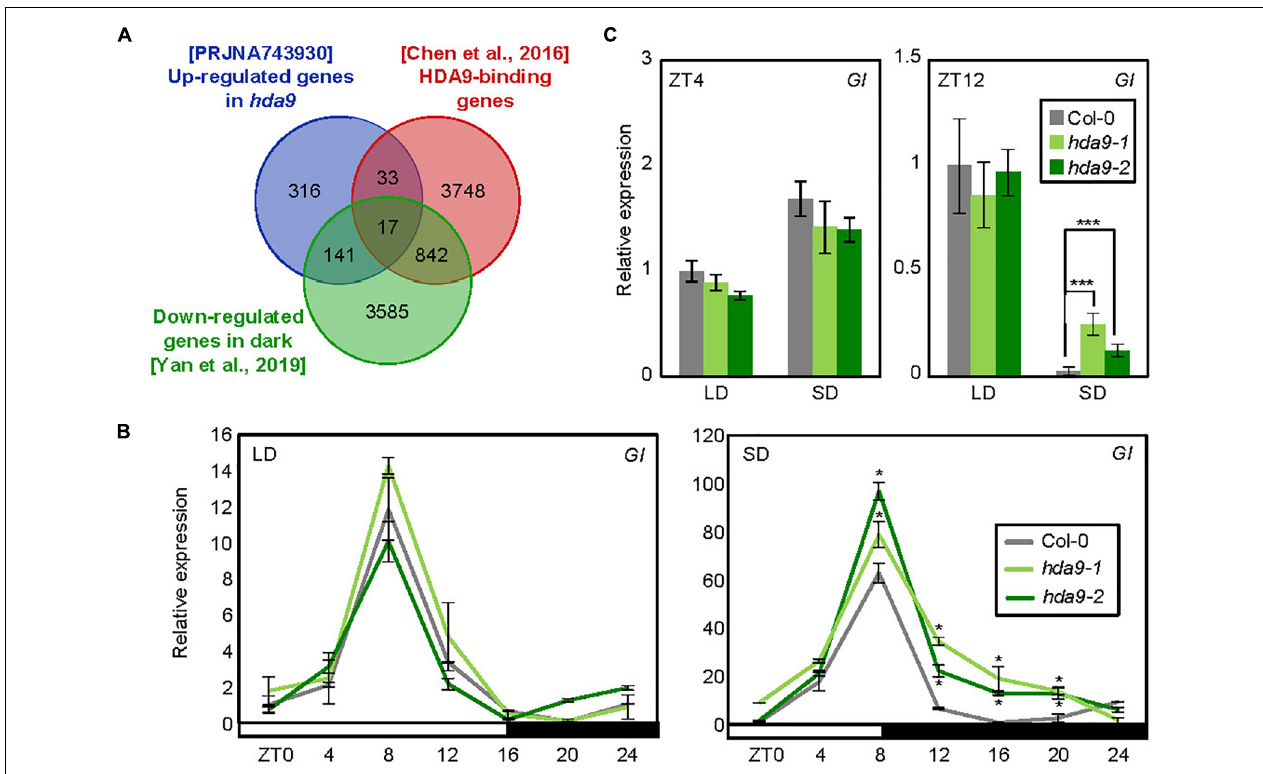
FIGURE 3 | HDA9 represses GIGANTEA ( GI ) expression during the dark period in short days (SDs). (A) Venn diagram analysis. The intersection of genes targeted by HDA9, up-regulated in hda9 mutants and down-regulated by darkness, was determined for downstream analysis. (B) GI expression in hda9-1 and hda9-2 mutants. Seven-day-old seedlings grown under long day (LD) and short day (SD) conditions ( n > 15) were harvested at different time points within a 24 h period (from ZT0 to ZT24). Gene expression levels were normalized relative to eIF4A expression. Error bars indicate standard error of mean (SEM). (C) Transcript level of GI in hda9 mutants in long days (LDs) and SDs. Whole seedlings were harvested at ZT4 and ZT12. Biological triplicates were averaged. Error bars indicate the SEM. Statistical significance of the measurements was analyzed by Student’s t -test (* P <